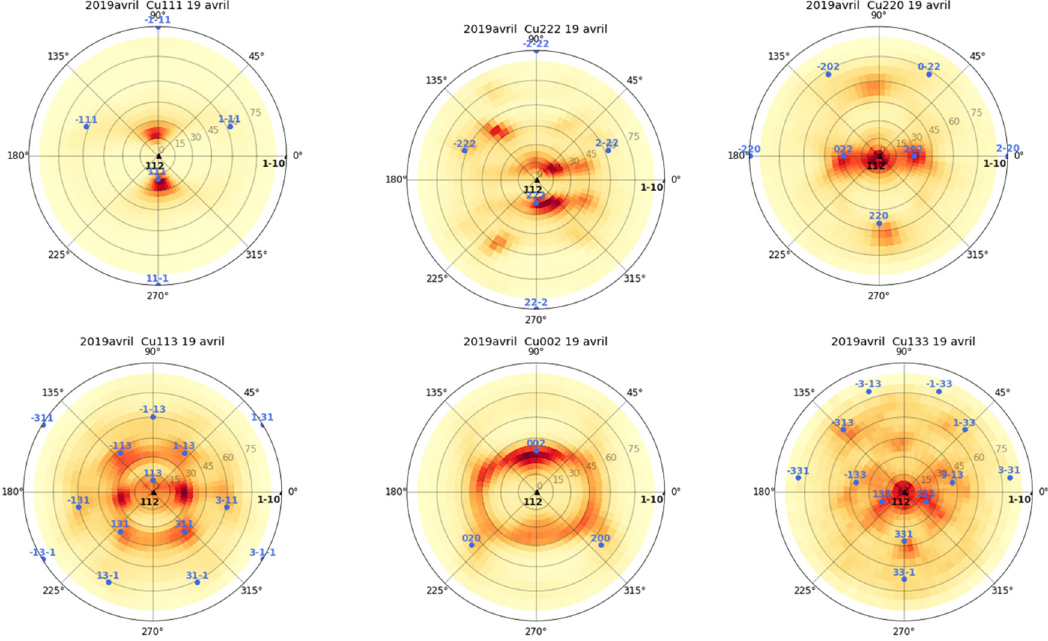
Figure 1. Pole figure measurements of copper in Cu(16)/Nb(16) ARB nanolaminate using a 4-axis diffractometer [57].